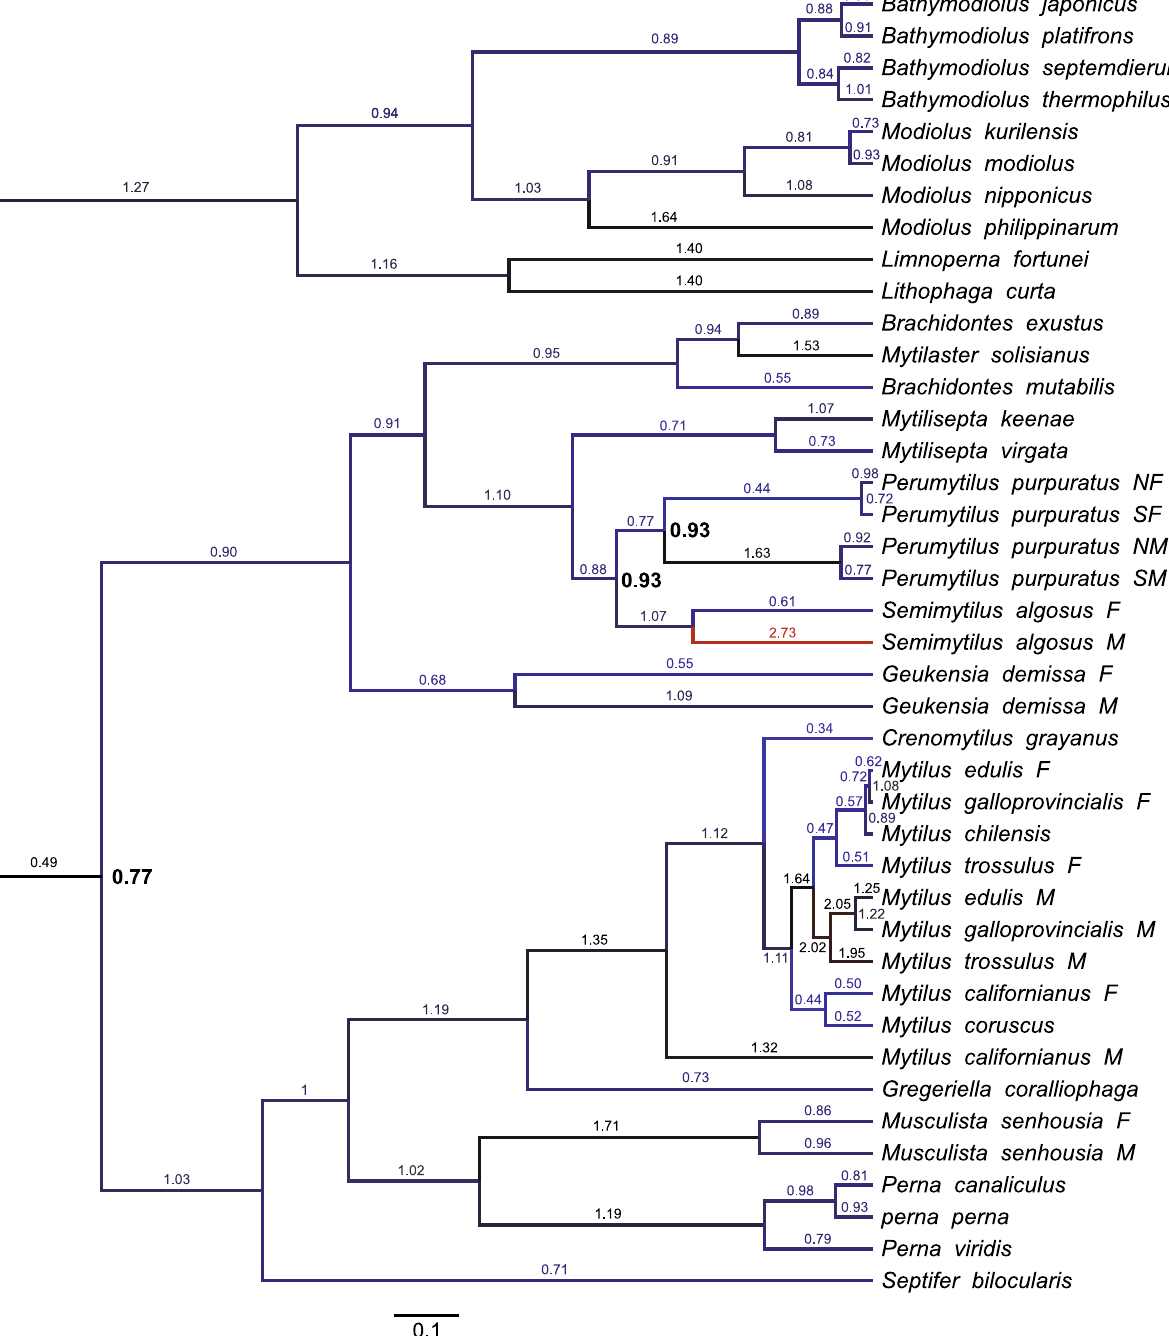
Figure 3. The phylogenetic position of Semimytilus algosus mitogenomes among mitogenomes of other mytilid mussels. Posterior probabilities of all bipartitions were 1.0, except for the nodes indicated by the bolded number. Numbers on branches represent evolutionary substitution